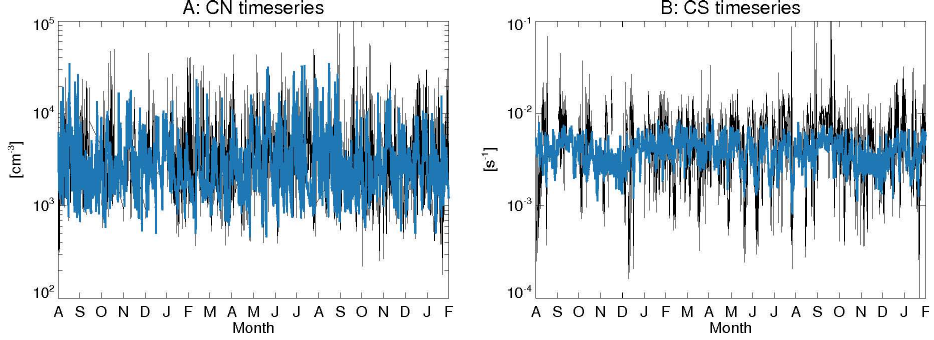
Fig. A2. Simulated (blue) and observed (black) time series of: (A) 10–840nm particles and (B) condensation sink for the period from 1 August 2006 to 31 January